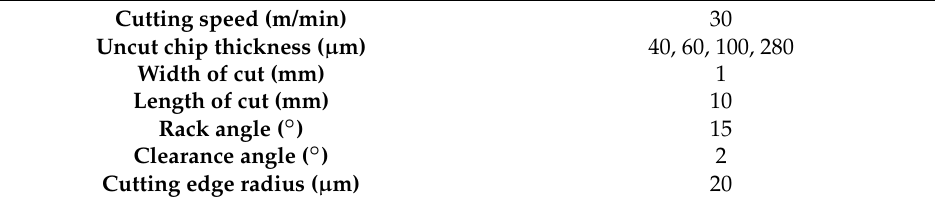
Table 2. Cutting conditions of the experiments